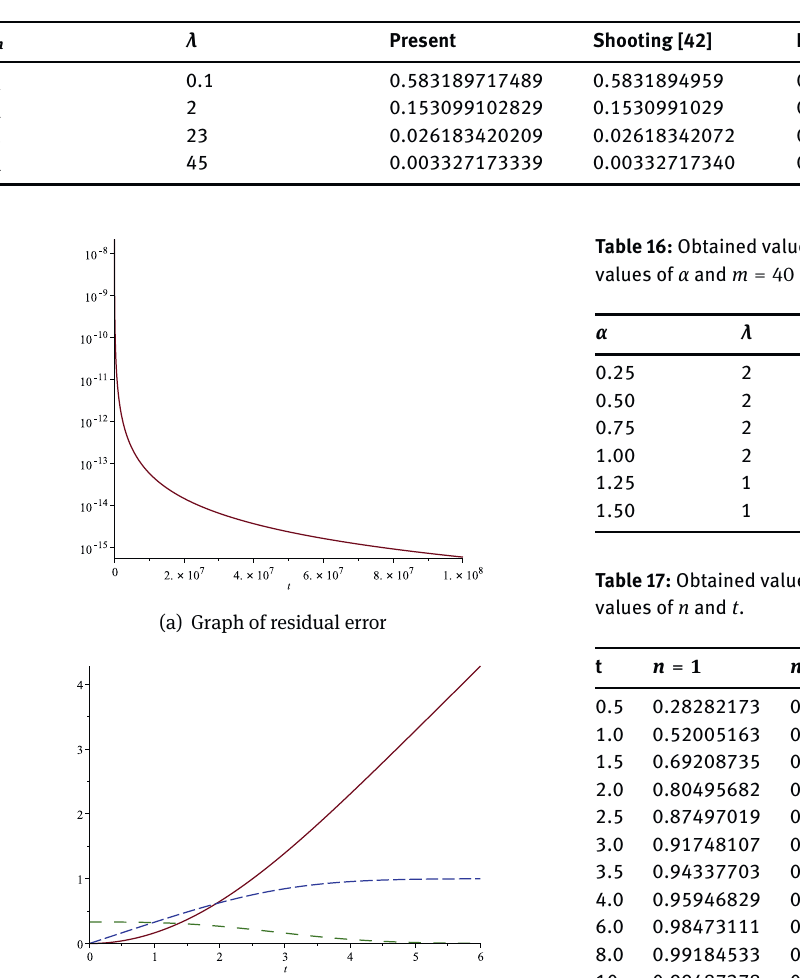
Table 14: Comparison of the obtained values of k n between the present method, Shooting method [42], Boisseau et al. [42], and Amore & Fernandez [43].